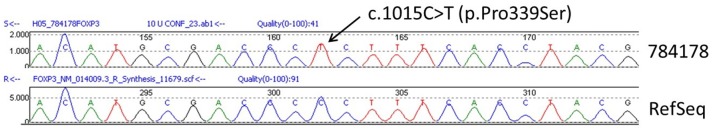
Confirmatory Sanger Sequencing of the FOXP3 c.1015C>T (p.Pro339Ser) mutation from the patient in relation to the reference sequence NM_014009.3 (RefSeq).